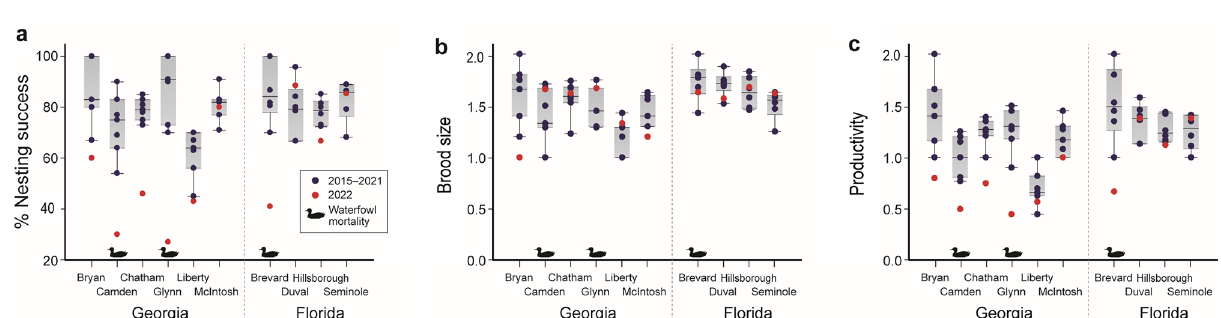
Figure 4. Bald eagle nest metrics (2015–2022) in selected counties of Georgia and Florida, USA where H5 highly pathogenic influenza A virus mortality in bald eagles was confirmed January—April 2022. ( a ) Bald eagle nest success. ( b ) Brood size (mean fledged bald eagles/successful nest). ( c ) Productivity (mean fledged bald eagles/occupied territory (GA) or /occupied nest (FL)). Red dots represent values for 2022. Duck